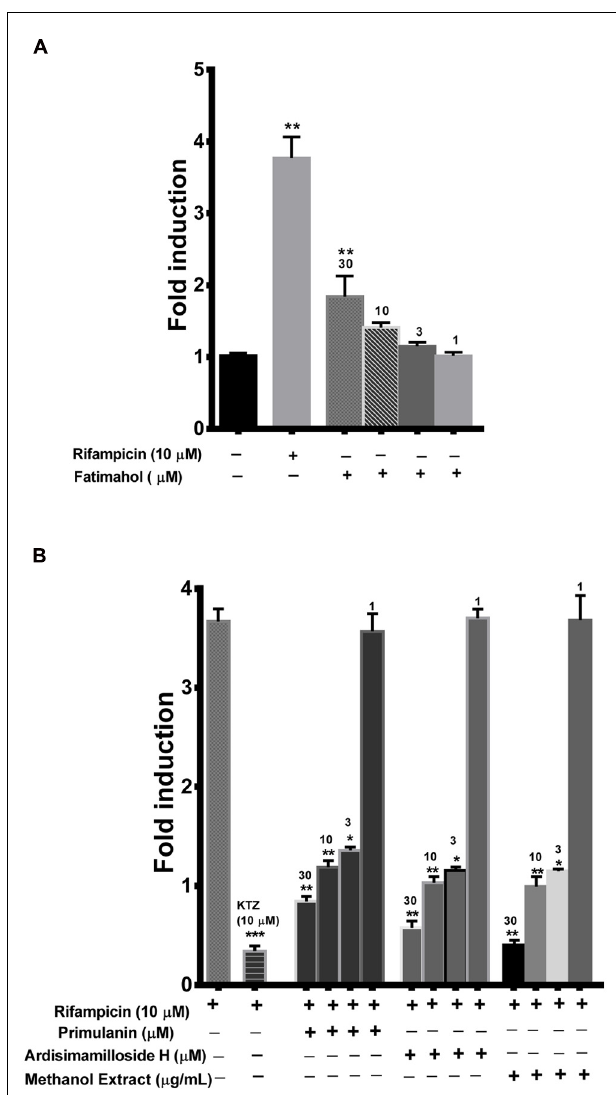
FIGURE 7 | Induction of PXR by fatimahol and rifampicin (A) and inhibition of rifampicin mediated induction of PXR by Labisia pumila methanol extract and its constituents (B) at indicated concentrations. Ketoconazole (KTZ) was used as a positive control in the inhibition assay. * P < 0.05, ** P < 0.01, and *** P < 0.001, determined by One way ANOVA, followed by Dunnett’s multiple comparison tests.The data are represented as mean ± SD of triplicate measurements in three independent